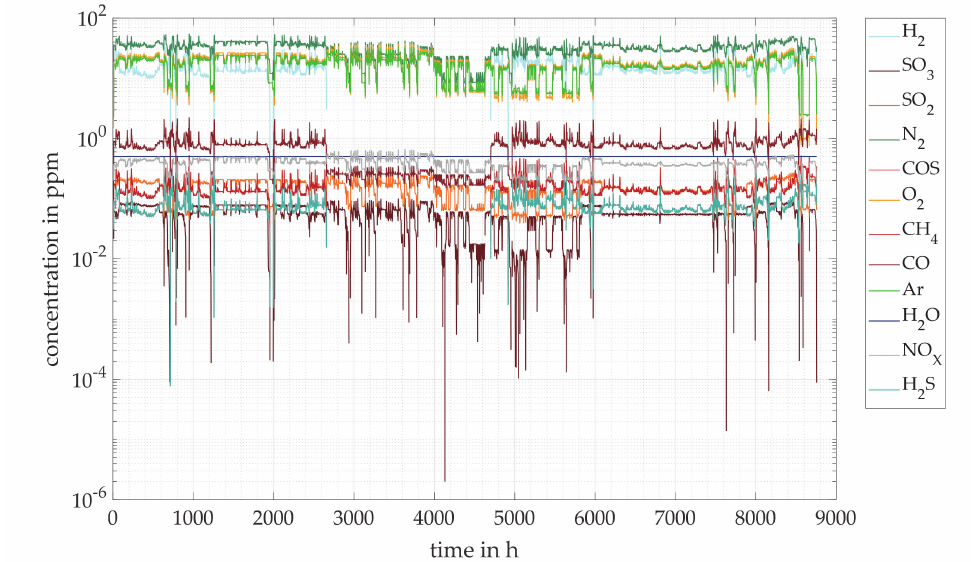
Figure 7. Simulated variation (hourly averages) of individual impurity concentrations within the CO 2 stream at the entry of the trunk pipeline throughout one year ( = 8760 h) for the scenario “RE 45%” (T = 288 K, p inlet ≤ 12.41 MPa; note that COS concentration data are hidden behind the H 2 S data as its concentration values are identical to those of H 2 S throughout the